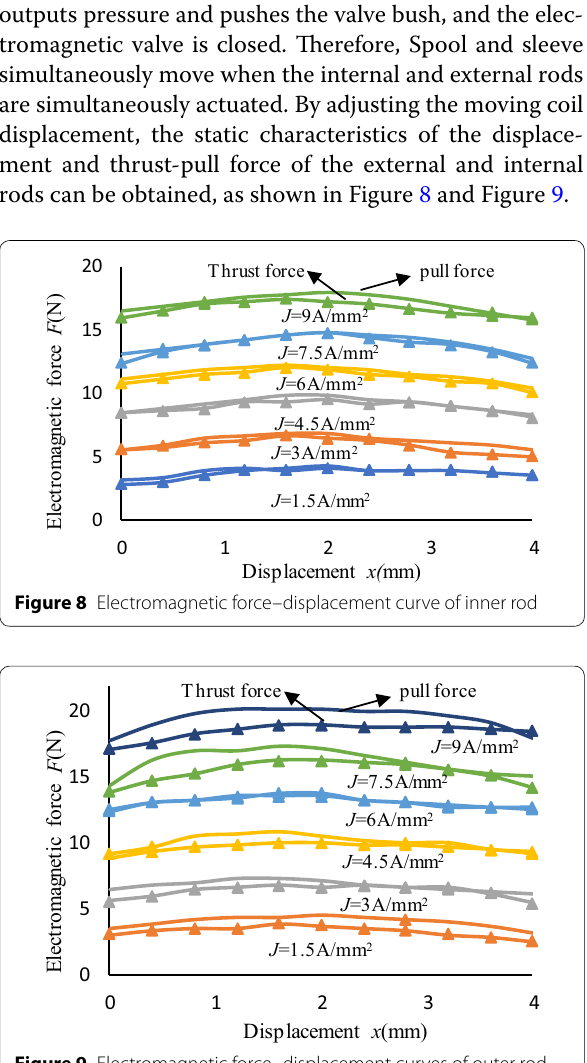
Figure 7 Test devices of double rod electromechanical converter